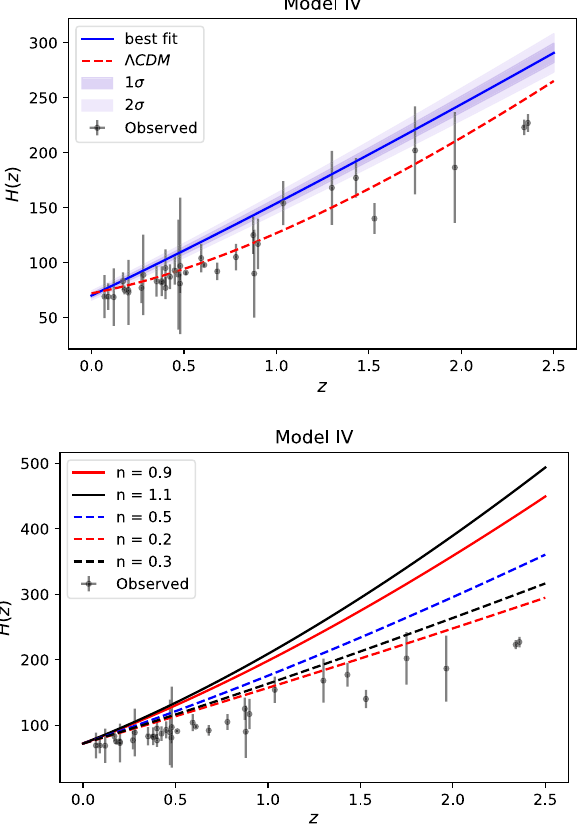
Fig. 8 Plots of the reconstructed Hubble parameter H ( z ) for Model IV , general combination of power law potential. The best fit values and the associated 1 σ , 2 σ confidence regions are obtained from the combined analysis. Hubble parameter plots using different values of n for Model IV are also